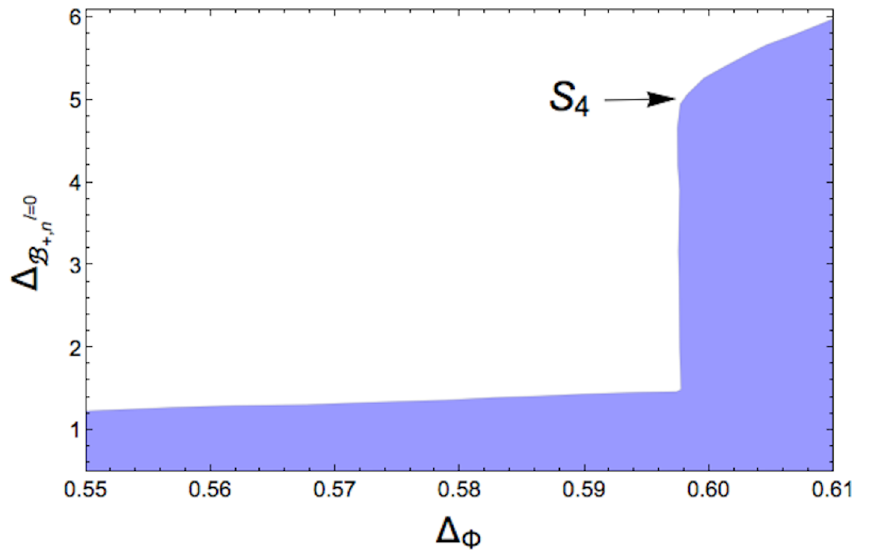
Figure 1 . Bound on the scaling dimension of the leading operator transforming in 3 -dimension of S 4 , which is T-parity even. The numerics is preformed at Λ = 13